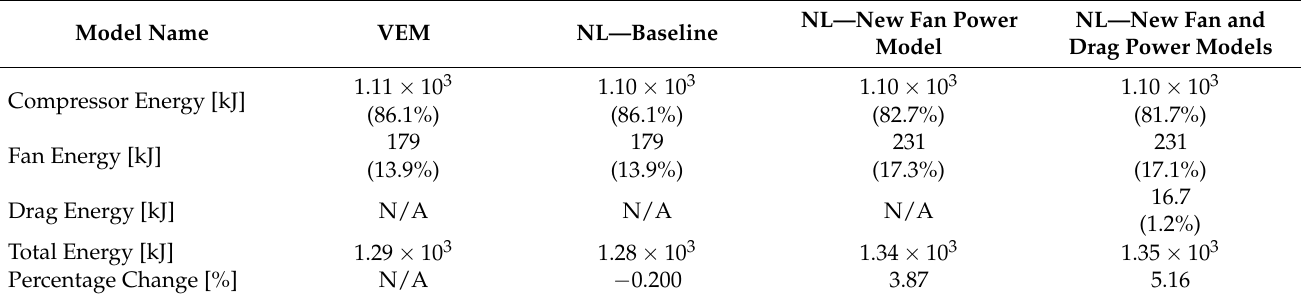
Table 6. Energy consumption comparison for SC03 cycle.